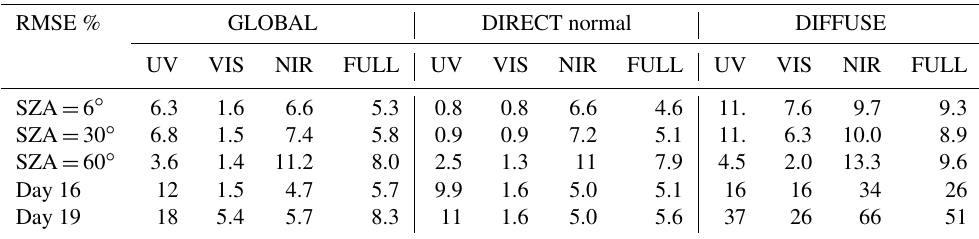
Table 2. RMSE in percentage (%) evaluated in the comparison between SSolar-GOA and libRadtran models for the three solar components and the three SZAs. The same for the day 16 and 19 of Figs. 8 and 9 of the comparison between measured LI-1800 and modelled SSolar-GOA irradiance